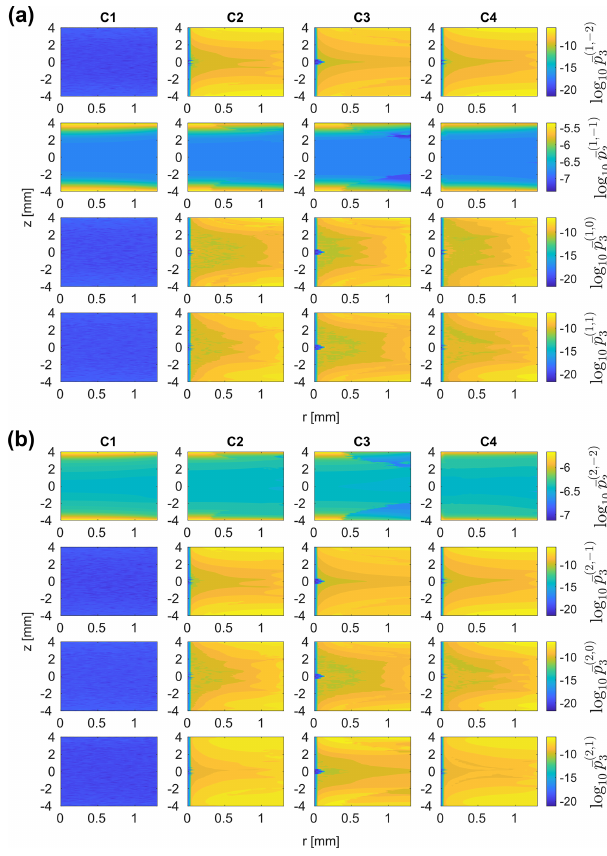
Figure 14. Magnitude of the scaling factors of the three-spin contri- bution to the dipolar–dipolar cross-terms in the second-order effec- tive Hamiltonian during FSLG decoupling with an rf field strength of 125kHz along the magic angle at a MAS frequency of 12.5kHz in a 3.2mm MAS probe. The resulting magnitudes are shown for n 1 = 1 (a) and n 1 = 2 (b) for all possible n 2 values with a logarith- mic scale. The largest scaling factors are obtained for combinations where n 1 + n 2 = 0; however, no difference between C1–C4 is ob- served. For other n 1 ,n 2 pairs, significantly larger scaling factors result when rf modulations are present (C2, C3, and C4). Never- theless, they remain several orders of magnitude smaller than the first-order